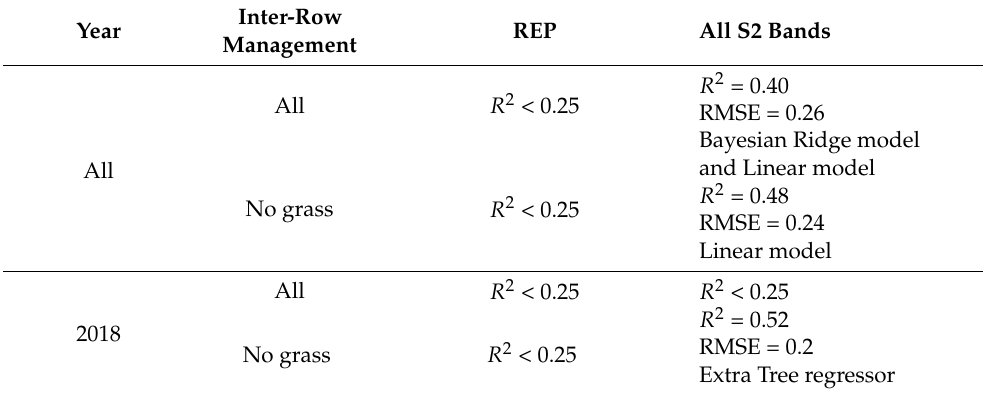
Table 9. Summary of the best algorithms for every subplot with R 2 ≥ 0.25 and RMSE ≤